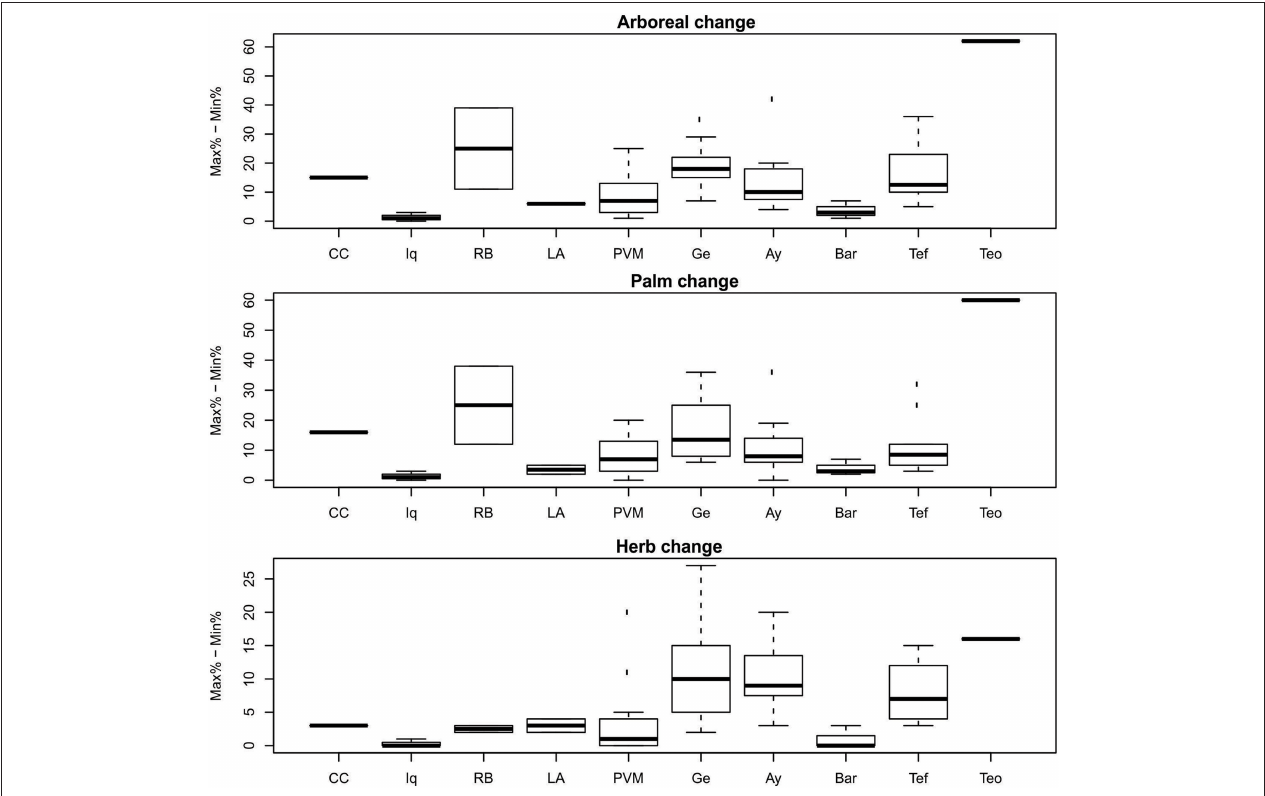
FIGURE 6 | Magnitude of change in phytolith percentages within a core. Regional codes are the same as listed in Figure 3 . See Table 1 for total number of samples analyzed from each region.